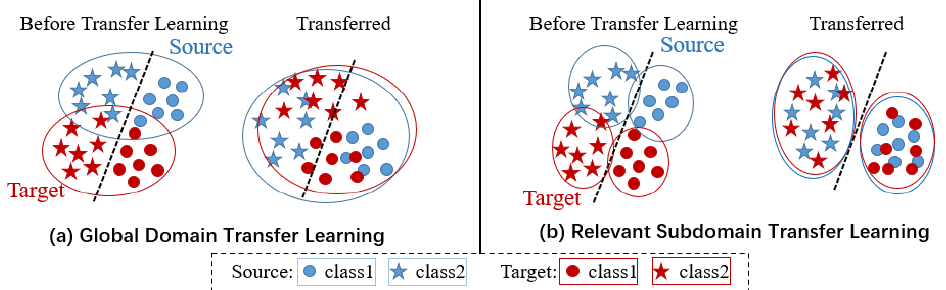
Figure 3. ( a ) Global domain transfer learning can’t achieve the alignment of the distribution for the same class. ( b ) relevant subdomain transfer learning can align the distribution of the same class and make the subdomain be separated for each category. (The dots and stars represent different categories, with the stars representing class 1 and the dots representing class 2; different colors represent different domains, with blue representing source domain characteristics and red representing target domain characteristics).